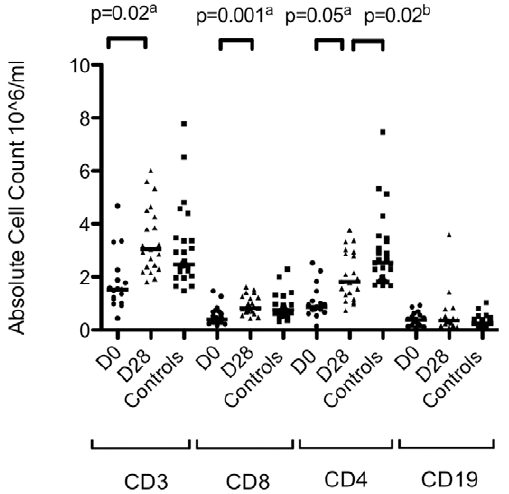
Figure 1. Cellular frequencies in P. falciparum infected and uninfected children. There is a significant decrease in the numbers of CD3, CD8 and CD4 positive cells in acute uncomplicated P. falciparum malaria (D0, circles), compared to cell numbers during convalescence in the same donors (D28, triangles). The number of CD4 positive cells on convalescence remains significantly lower than age- and sex- matched healthy controls (squares). The number of CD19 positive B-cells doesn’t significantly differ. a P value calculated using Wilcoxon rank statistical comparison of matched pairs. b P value calculated using the Mann- Whitney U comparison of unpaired